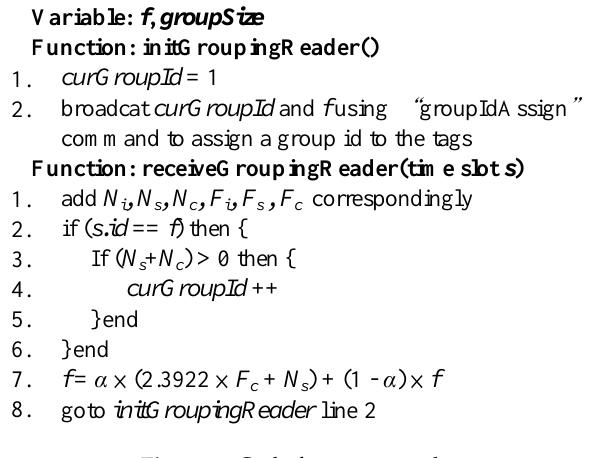
Figure 8. Code for group reader.